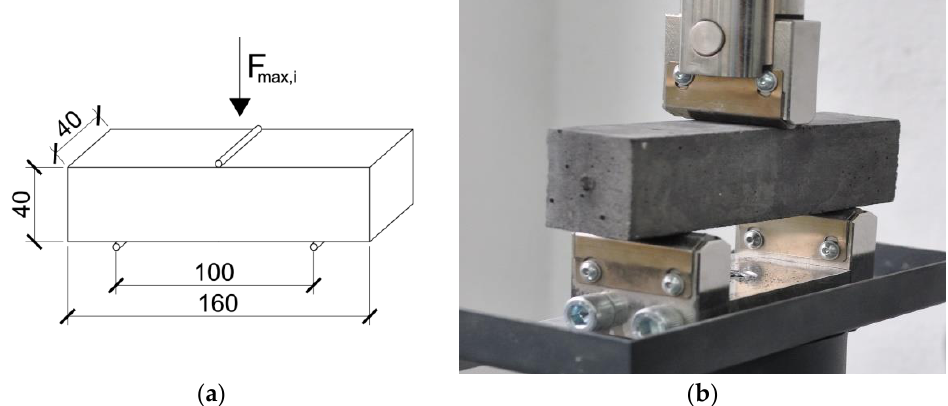
Figure 1. Determination of flexural strength: ( a ) dimensions of the beam-specimens and static scheme; ( b ) the view of the specimens in testing machine ready to test.